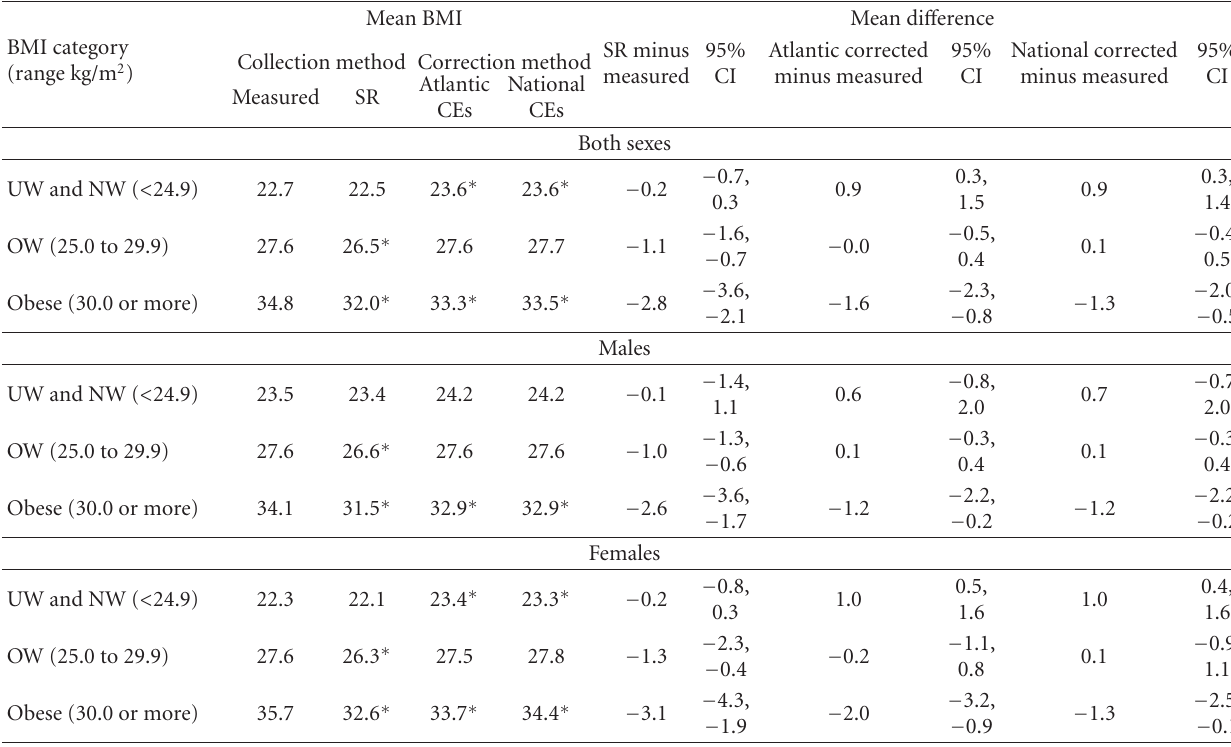
Table 3: Mean body mass index (BMI) and mean di ff erence between measured and self-reported or corrected BMI, by collection method, sex, and BMI category, household population aged 18 years or older, Atlantic Canada, 2007-2008. Mean BMI category